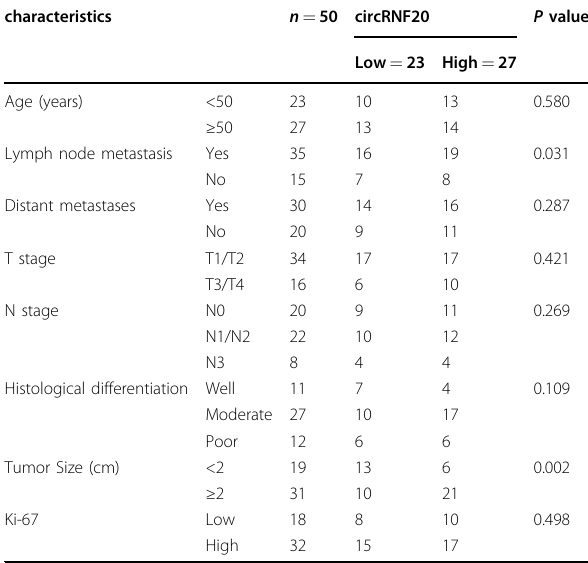
Table 1 The correlation of circRNF20 and the characteristics of BC